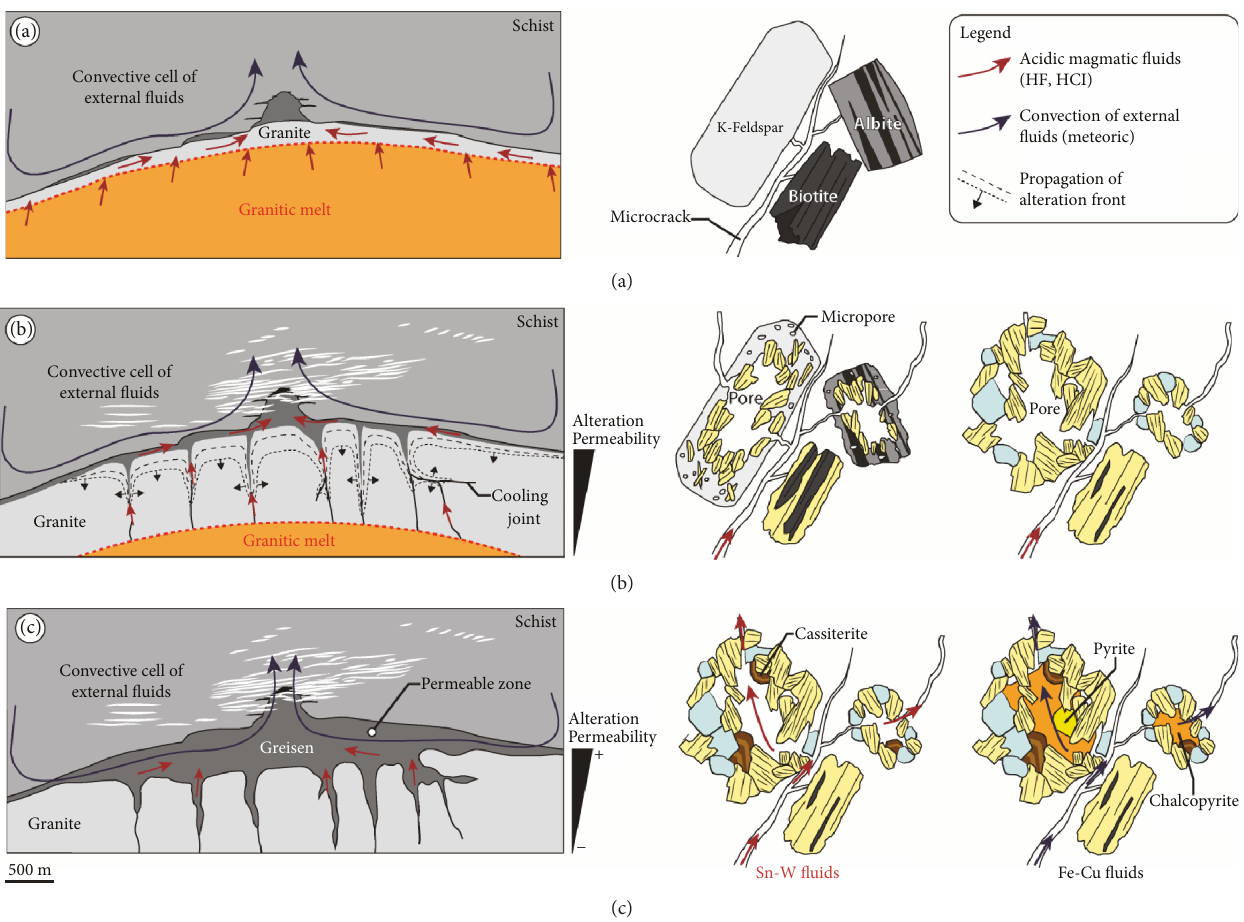
Figure 14: Conceptual model incorporating the evolution of permeability over time induced by replacement reactions related to greisenization of the Panasqueira granite. (a) Initiation of granite cooling and fl uid fl ow, which trigger the greisenization of the granite along the granite-schist contact (permeable interface). (b) Alteration of the granite leading to the progressive replacement of feldspars and biotite by muscovite. This mineralogical transformation is accompanied by the generation of porosity resulting from the decrease in molar volume associated with the replacement reactions. A positive feedback between greisen alteration and permeability is assumed here to explain the propagation of the greisenization front and the development of massive greisen. (c) The porosity generated by the greisen alteration enhances permeability and creates a potential permeable zone that can enhance fl uid fl ow and metal transport. The presence of metal bearing-minerals (cassiterite and sul fi des) in the newly formed greisen ’ s porosity seems to con fi rm the role of massive greisen as a drain for mineralizing fl uids and to explain the formation of this type of